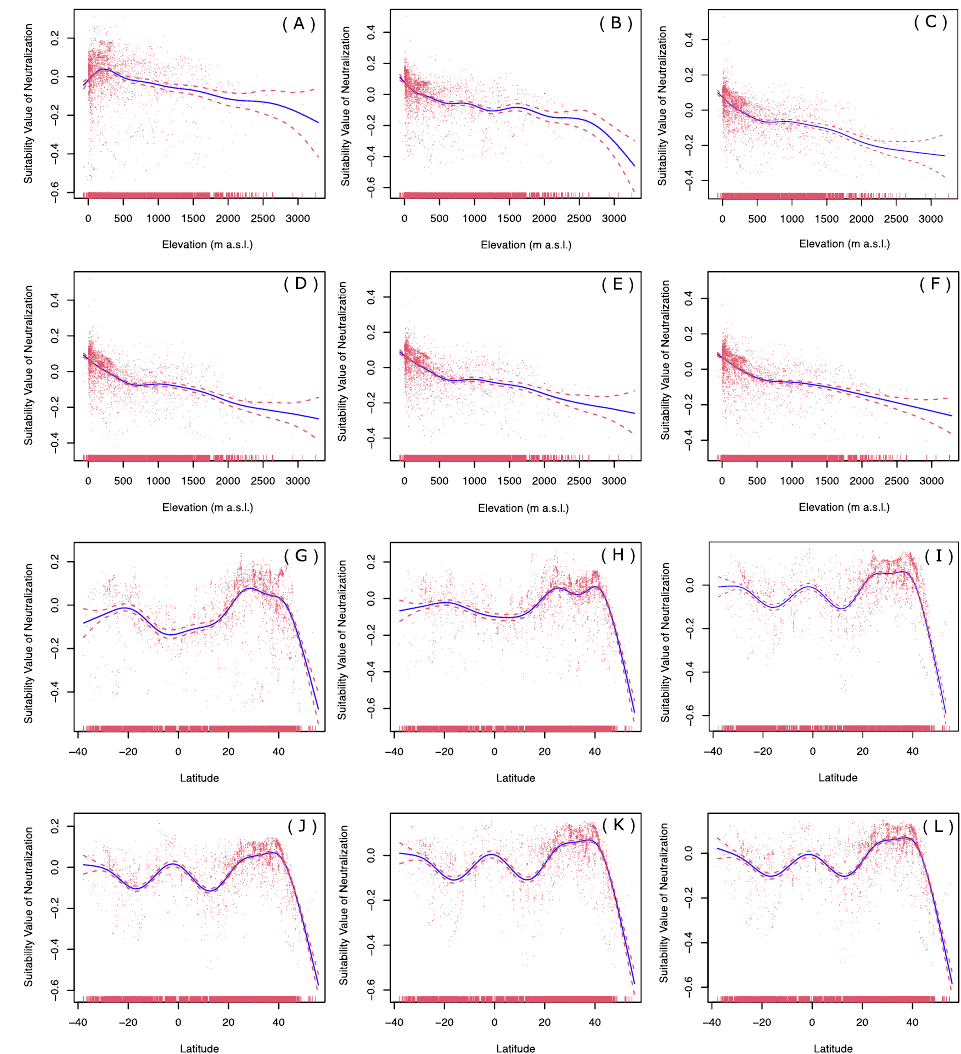
Figure 7. Changes in elevation and latitude of P. flavescens distribution over long time scales based on generalized additive model. All suitability values are neutralized by GAM function. ( A ) Elevations vs historical suitability value; ( B ) elevation vs current suitability value; ( C ) elevation vs future SSP1-2.6 suitability value; ( D ) elevation vs future SSP2-4.5 suitability value; ( E ) elevation vs future SSP3-7.0 suitability value; ( F ) elevation vs future SSP5-8.5 suitability value; ( G ) latitude vs